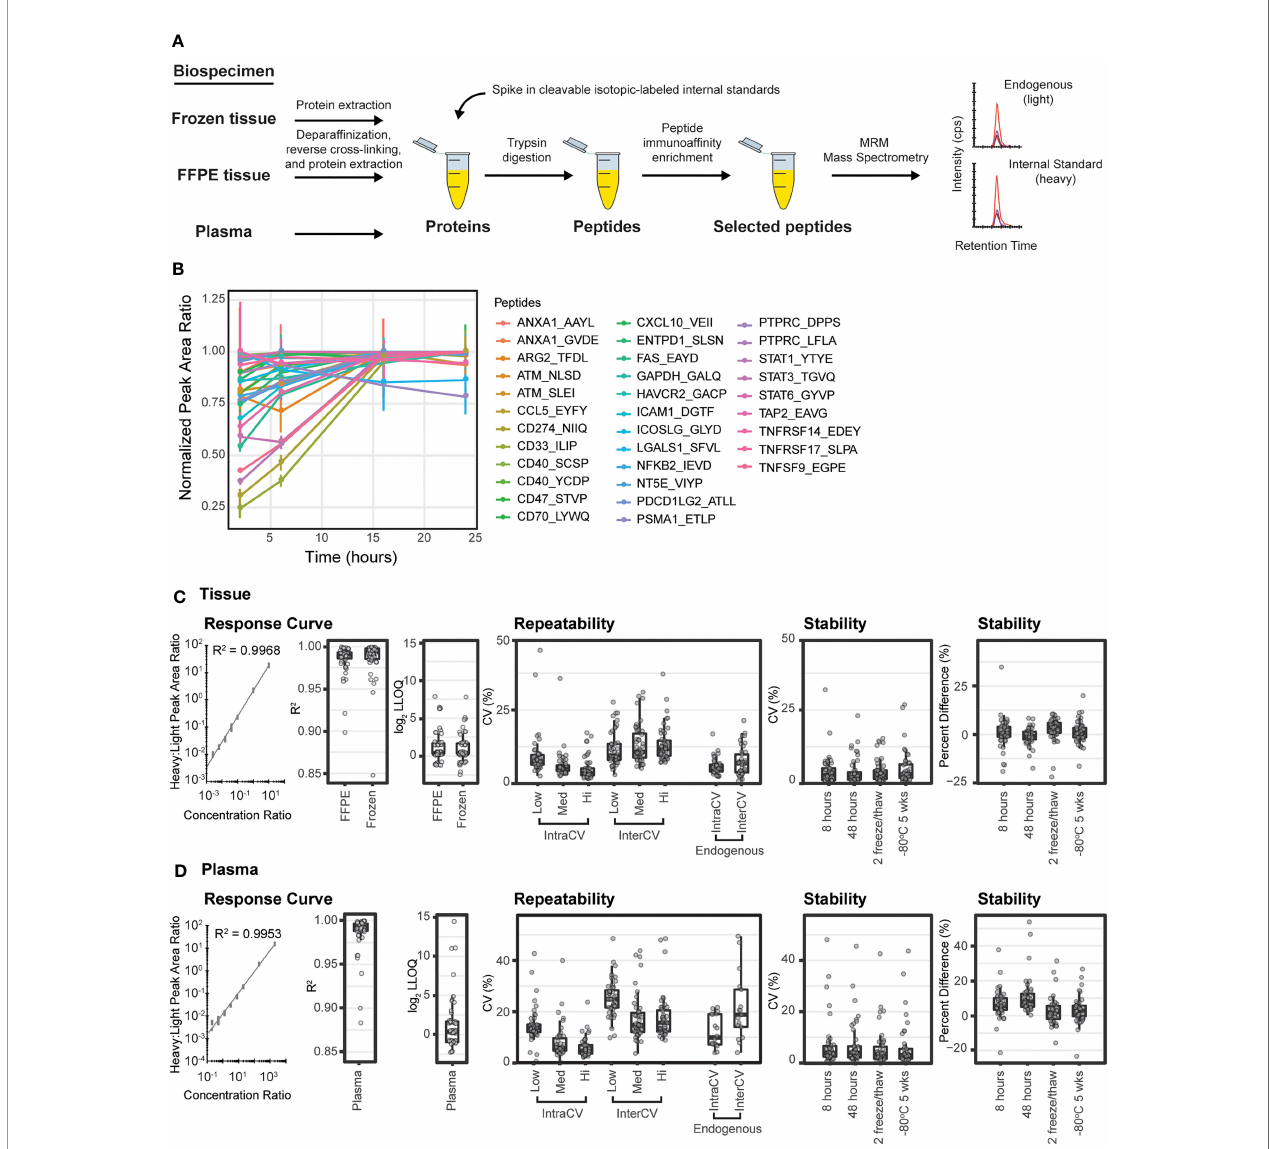
FIGURE 1 | Immuno-MRM enables highly multiplexed protein quanti fi cation. (A) The immuno-MRM assay work fl ow commences with generation of a protein lysate from the biospecimen of interest. Cleavable stable isotope labeled standards unique to each targeted peptide sequence are spiked into the sample at a known concentration. The protein mixture is converted to peptides by enzymatic digestion (Lys-C and trypsin). Custom monoclonal antibodies coupled to magnetic beads are used to enrich the endogenous peptides and labeled standards. The eluate is analyzed by multiple reaction monitoring-mass spectrometry, where analyte peptides and internal standards coelute with equivalent relative areas of monitored transitions. High sensitivity is achieved through analyte enrichment and optimization of mass spectrometer parameters for the targeted peptides. High speci fi city is maintained through optimal selection of fragment ion transitions. (B) Trypsin-mediated release of peptides was produced by overnight enzymatic digestion of proteins from a pool of cell lysates. The peak area ratios (light:heavy) for the 33 endogenous peptides detected were normalized to the maximum timepoint and plotted over time. Error bars are the standard deviation of three replicates. (C) Performance fi gures of merit for assays characterized in tissue matrix. (D) Performance fi gures of merit for assays characterized in plasma matrix. A representative response curve for the peptide VEIIATMK from CXCL10. Each concentration point was measured in triplicate. Distribution of R 2 values from linear regression of the response curves. Distribution of lower limit of quanti fi cation (LOQ) where each point refers to concentration determined by the lowest point on the curve with less than 20% CV. Repeatability is characterized by the distribution of CV values for intra- (within day) and inter- (between day) variability at three concentrations, in addition to the measurement of endogenous peptide. Each point corresponds to the average %CV for a peptide measured at three concentrations, Low (Lo), Medium (Med), and High (Hi) in triplicate over fi ve days (n=15 at each concentration for a peptide). Endogenous measurements refer to the intra (within day) and inter- (between day) variability of endogenous peptides detected above the LOQ in fi ve replicates measured over 5 days (n = 25). Stability shows the distribution of %CV and relative percent difference for 4 conditions compared to immediate analysis: (i) stored at 8 hours at 4°C, (ii) 48 hours at 4°C, (iii) after two freeze-thaw cycles, and (iv) stored at -80°C for 5 weeks. For box plots, the line shows the median value, boxes show the inner quartiles, and the whiskers show 5-95% of